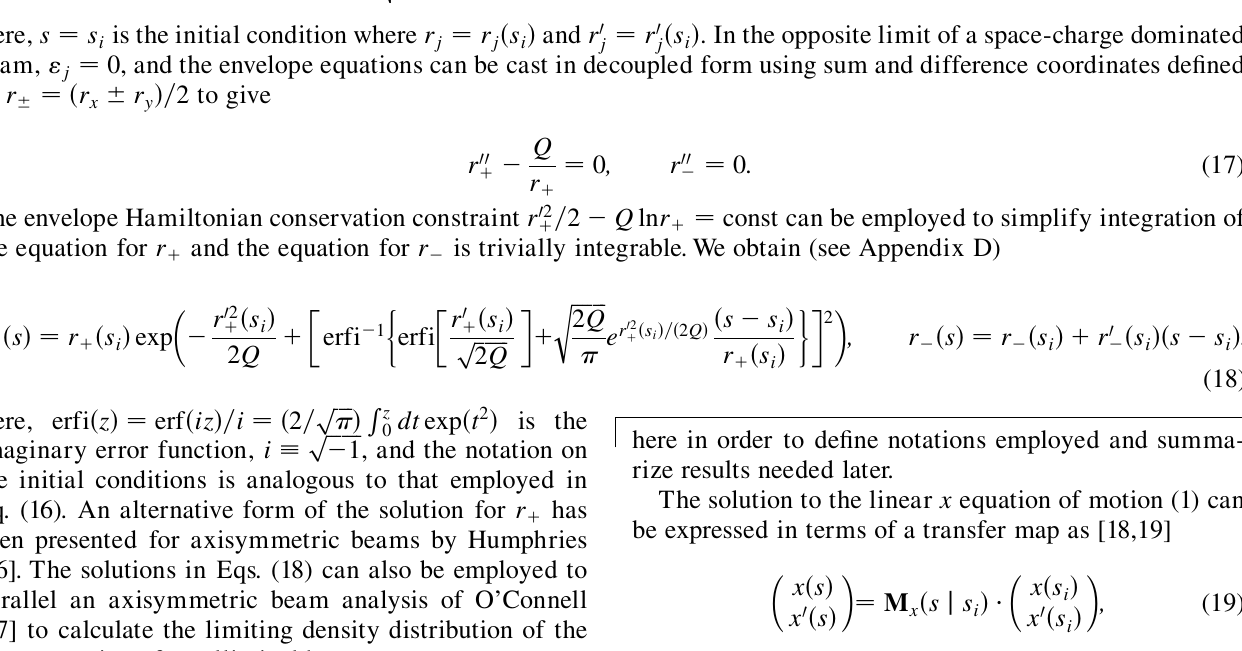
FIG. 3. Scaled envelope free expansions r (cid:4) plotted versus axial coordinate s (cid:2) s r (cid:5) (cid:3) s (cid:4) =r (cid:5) (cid:3) s i correspond to the emittance-dominated ( Q (cid:1) 0 ) and